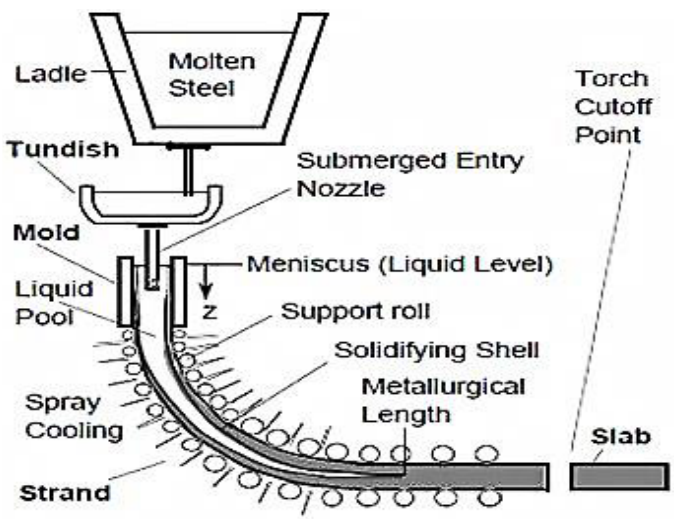
Figure 2. Detailed schematic of thick slab continuous caster (reproduced from [11], with permission from Iron & Steel Society, 1997).